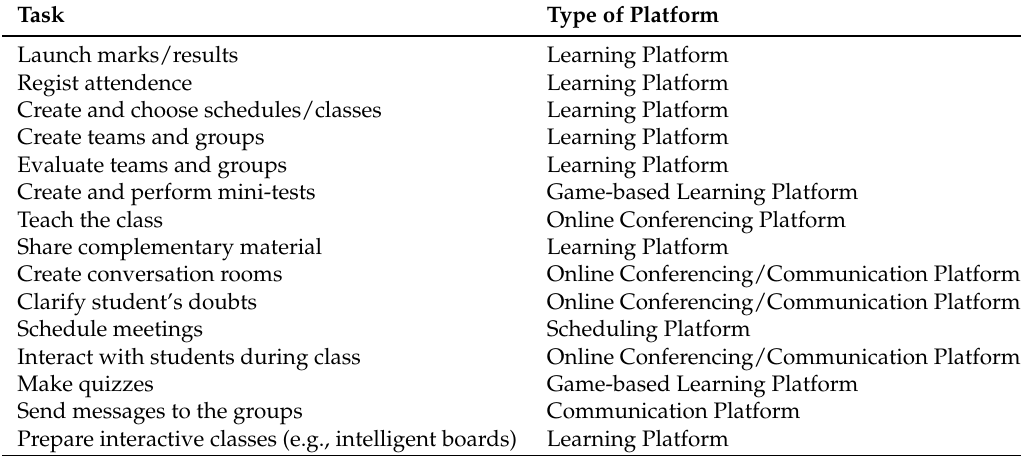
Table 11. Tasks vs.